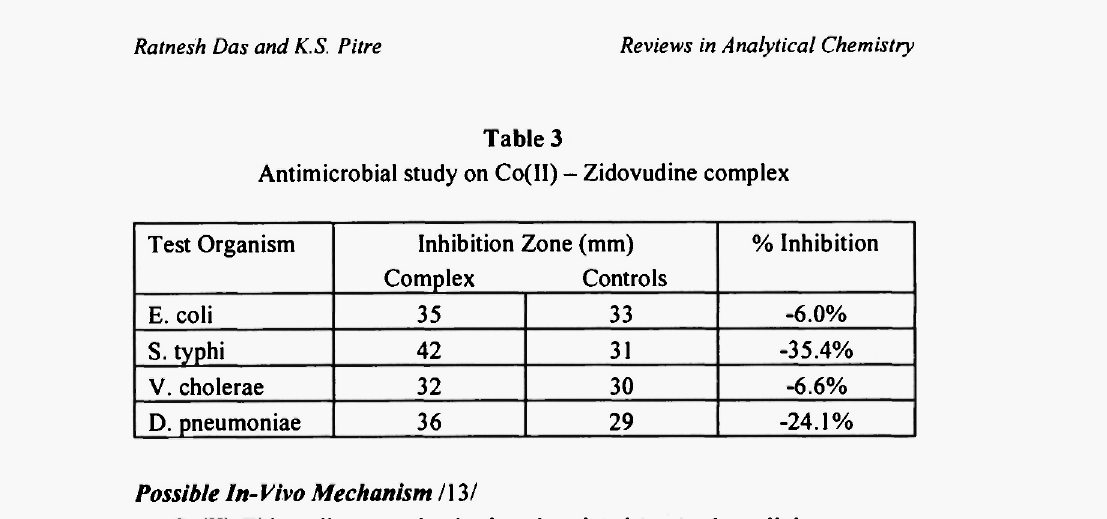
Antimicrobial study on Co(II) - Zidovudine complex Test